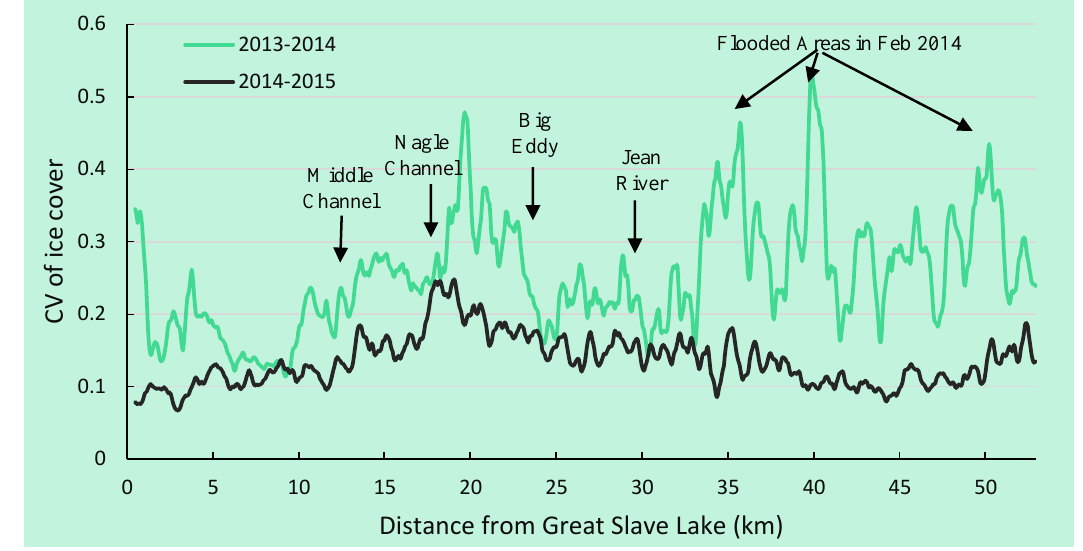
Figure 10. Inter-annual variation in ice cover along the Slave River Delta channel during the freeze-up period (mid-December to end-February) in the winters 2013–2014 and 2014–2015.